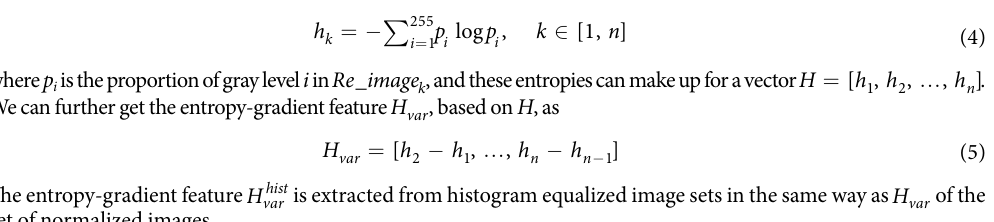
Table 2. Distribution of patient cases by IR features. Prevalence = number of metastatic cases divided by number of cases with the given IR